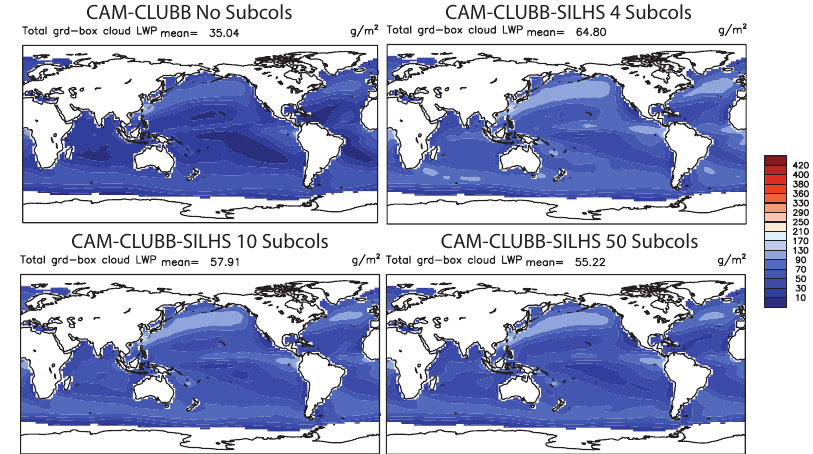
Figure 14. LWP for 5 years of simulation without subcolumns at all (top left), 4 subcolumns (top right), 10 subcolumns (bottom left), and 50 subcolumns (bottom right). Without subcolumns, the model has little cloud liquid water. The simulation with 4 subcolumns has a large amount of cloud liquid, which moderates in the 10 and 50 subcolumn